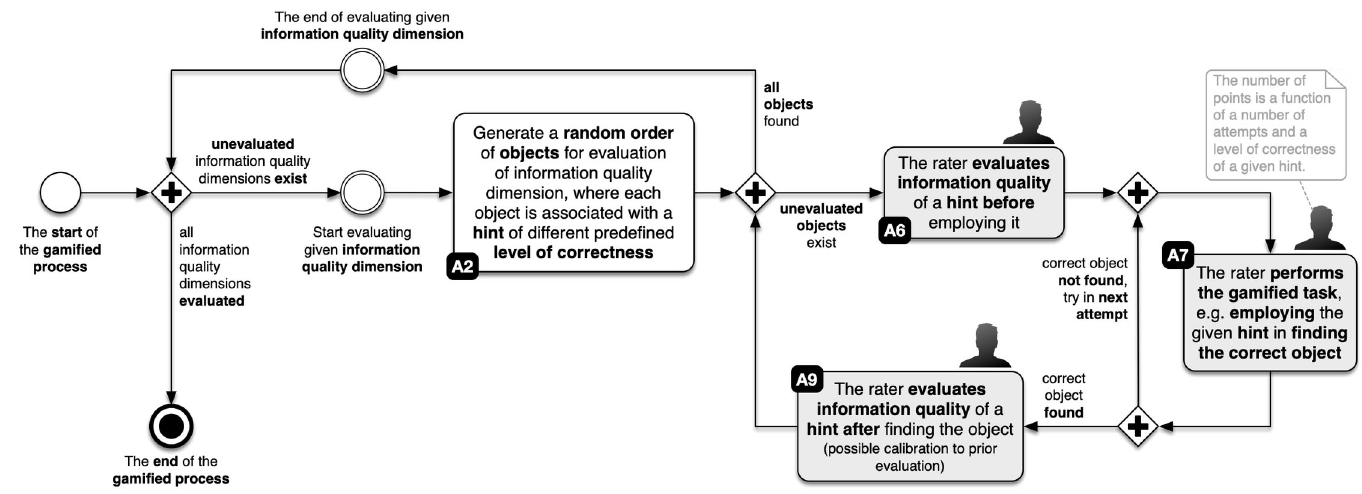
Fig 1. Overview of measuring selected IQ